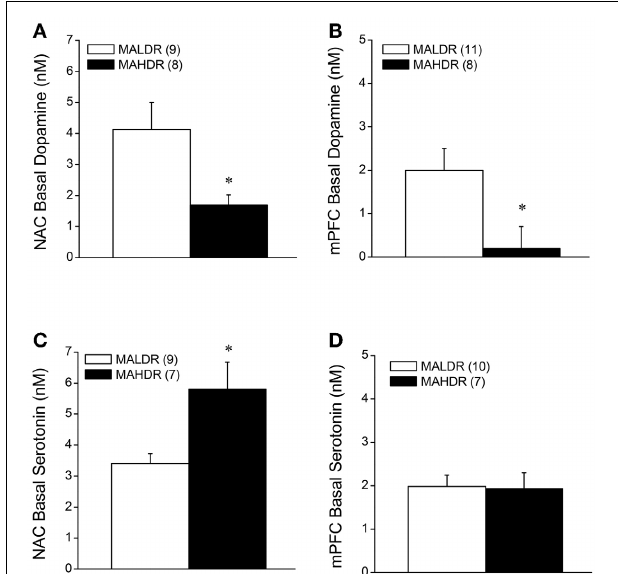
FIGURE 6 | Summary of the results of a dopamine (A,B) and serotonin (C,D) no net-flux in vivo microdialysis study conducted within the NAC core-shell interface (left) and mPFC (right) in MA-naïve mice on a genetically heterogeneous B6 × D2 background (F2B6D2) and mice selectively bred for high vs. low MA intake (MAHDR and MALDR, respectively). The data represent the means ± s.e.m’s of the number of animals indicated in parentheses in each panel. ∗ p < 0 . 05 vs. MALDR.